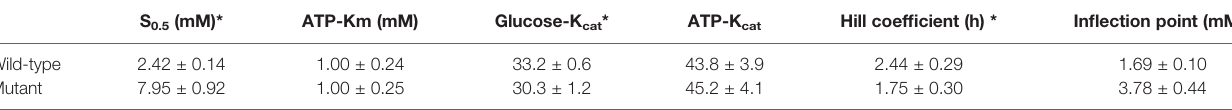
TABLE 2 | Kinetic parameters of the wild-type and mutant forms of His-GCK. S 0.5 (mM)* ATP-Km (mM) Glucose-K cat * ATP-K cat Hill coef fi cient (h) * In fl ection point (mM)* Wild-type 2.42 ± 0.14 1.00 ± 0.24 33.2 ± 0.6 43.8 ± 3.9 2.44 ± 0.29 1.69 ± 0.10 Mutant 7.95 ± 0.92 1.00 ± 0.25 30.3 ± 1.2 45.2 ± 4.1 1.75 ± 0.30 3.78 ± 0.44